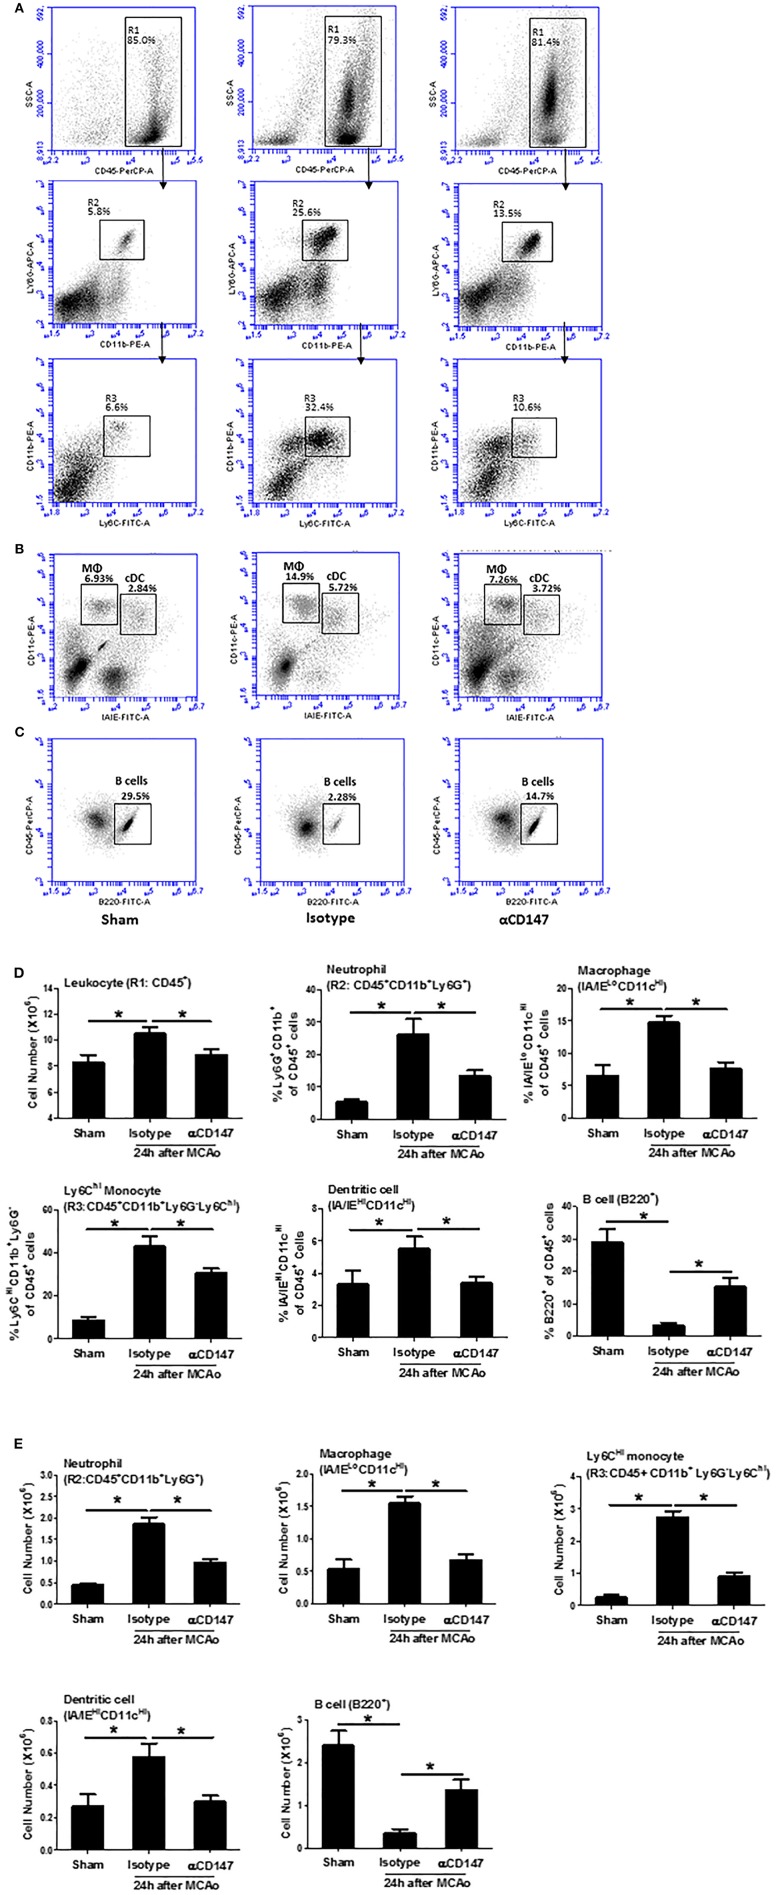
Inhibition of CD147 modulates the changes of leukocyte subpopulations in the lung after stroke. (A) Representative flow cytometric dot plots of R1: total leukocytes (CD45+), R2: neutrophils (CD45+CD11b+Ly6G+), and R3: ly6CHi monocytes (CD45+CD11b+Ly6G−Ly6CHi) in the isolated lung cells from indicated groups. Lung infiltrating cell was isolated using enzyme digestion method at 24 h after stroke. (B) Representative flow cytometric dot plots of lung conventional dendritic cell (cDC, identified as CD11cHi/IA/IEHi) and macrophage (MΦ, CD11cHi/IA/IELo) populations. (C) Representative flow cytometric dot plots of B cell population (B220+). (D,E) The number and frequency of cell subpopulations in the indicated groups. n = 6 per group. *P < 0.05.